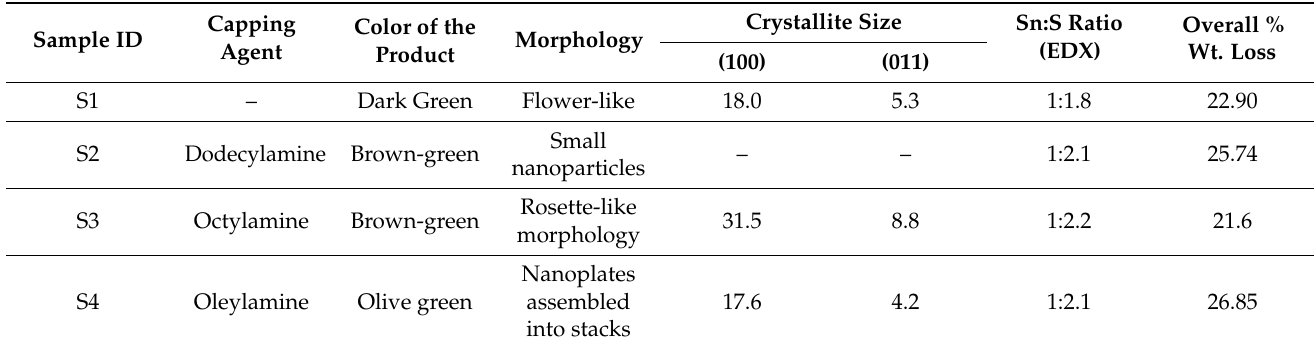
Table 1. Synthetic details, nomenclature, and morphology of all SnS 2